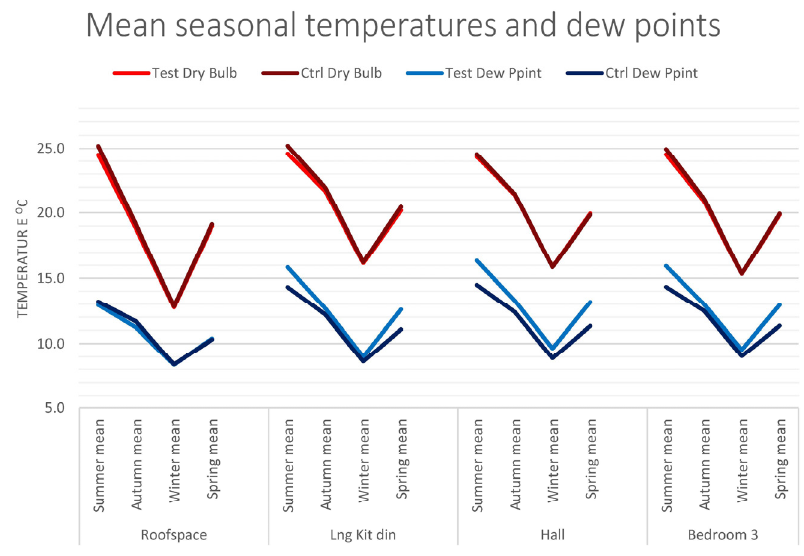
Figure 9. Comparison of space temperature and dew point seasonal means.